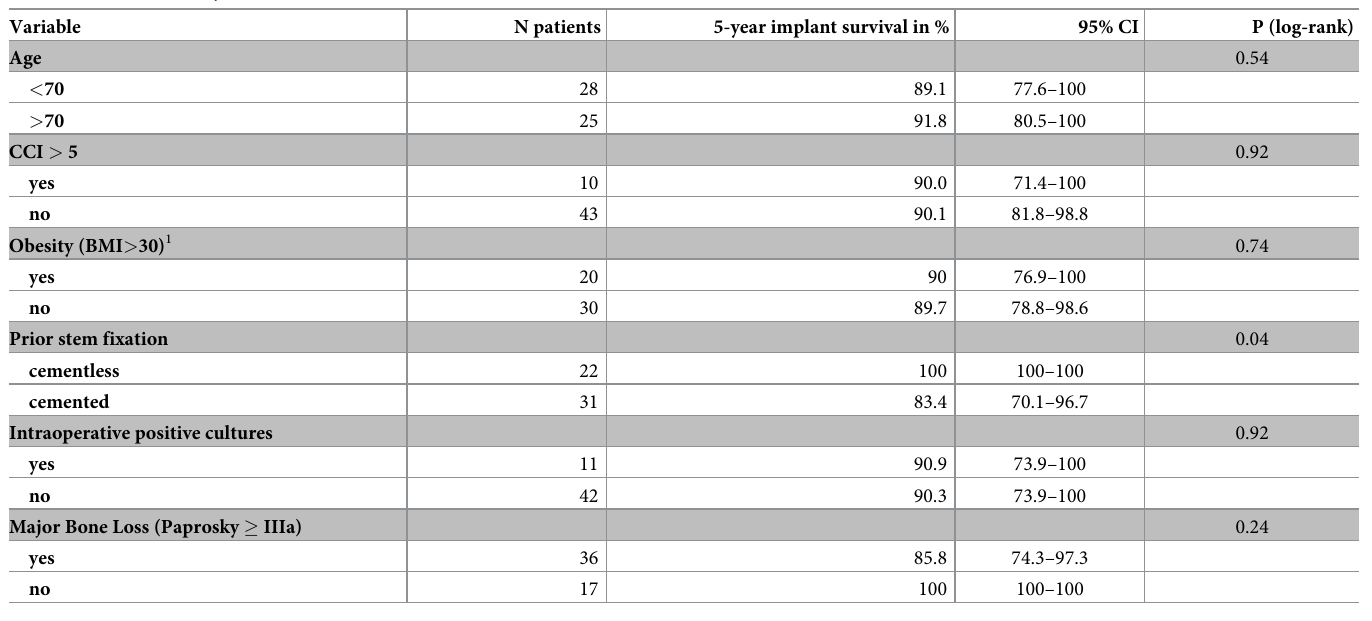
Table 4. Risk factor analysis.